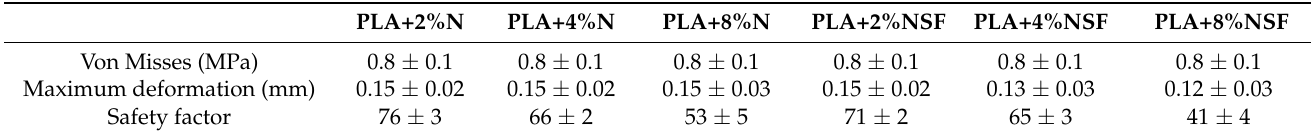
Table 9. Results for the second simulation using the new nanocomposites.